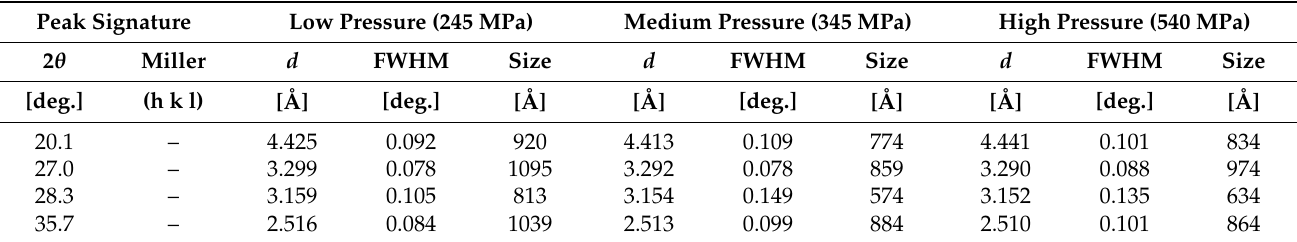
Table 3. XRD parameters of deconvoluted peak signatures for zirconia contaminants over different levels of pressure. Peak